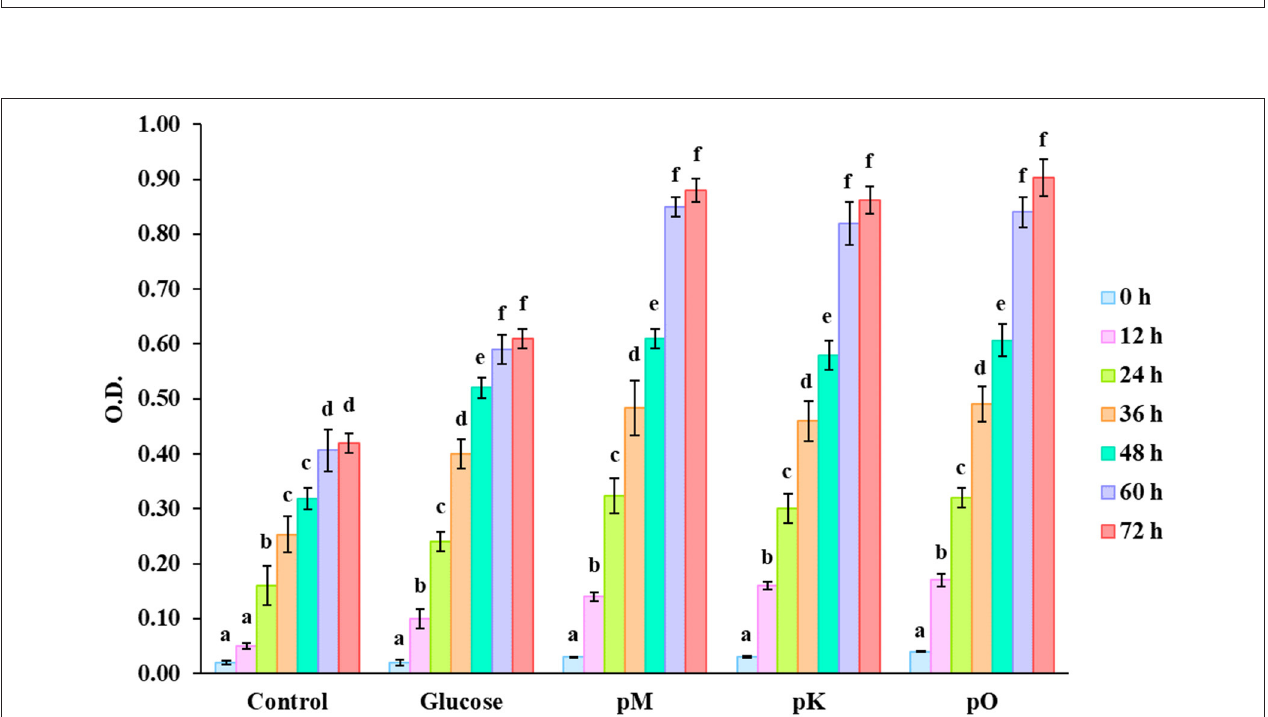
FIGURE 5 | O.D values of culture media with no carbon source; control, carbon source having glucose, pectin from Mosambi peels (pM), Kinnow peels (pK) and Orange peels (pO). Bars sharing the same letter within a treatment are not significantly different ( P < 0.05). Error bars represent standard deviation.